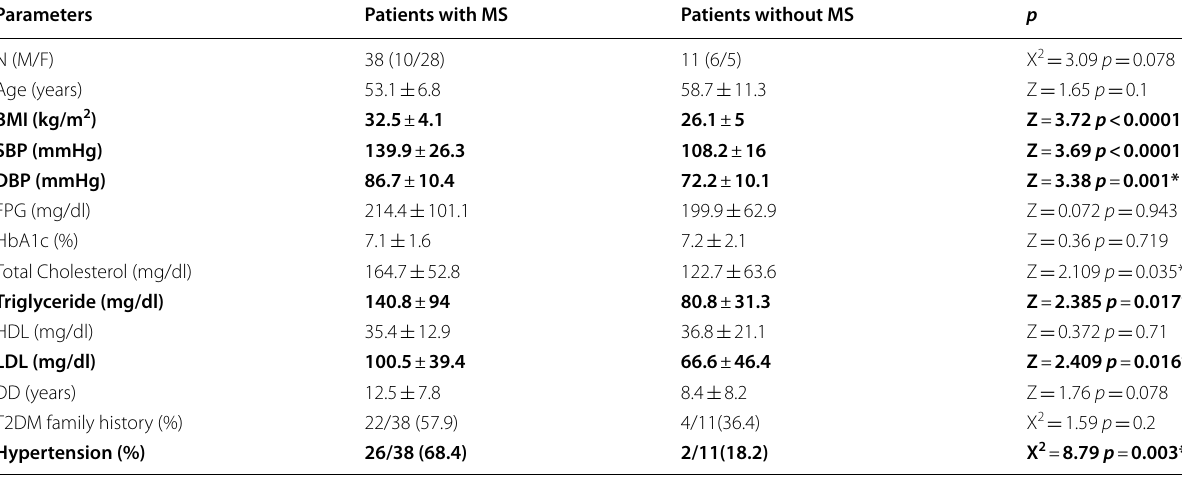
Bold indicates statistical significant result DD diabetes duration, BMI body mass index, GHb glycated hemoglobin, FPG fasting plasma glucose, SBP systolic blood pressure, DBP diastolic blood pressure, HDL-c high‑density lipoprotein cholesterol and LDL-c low density lipoprotein cholesterol *Significant value at P <